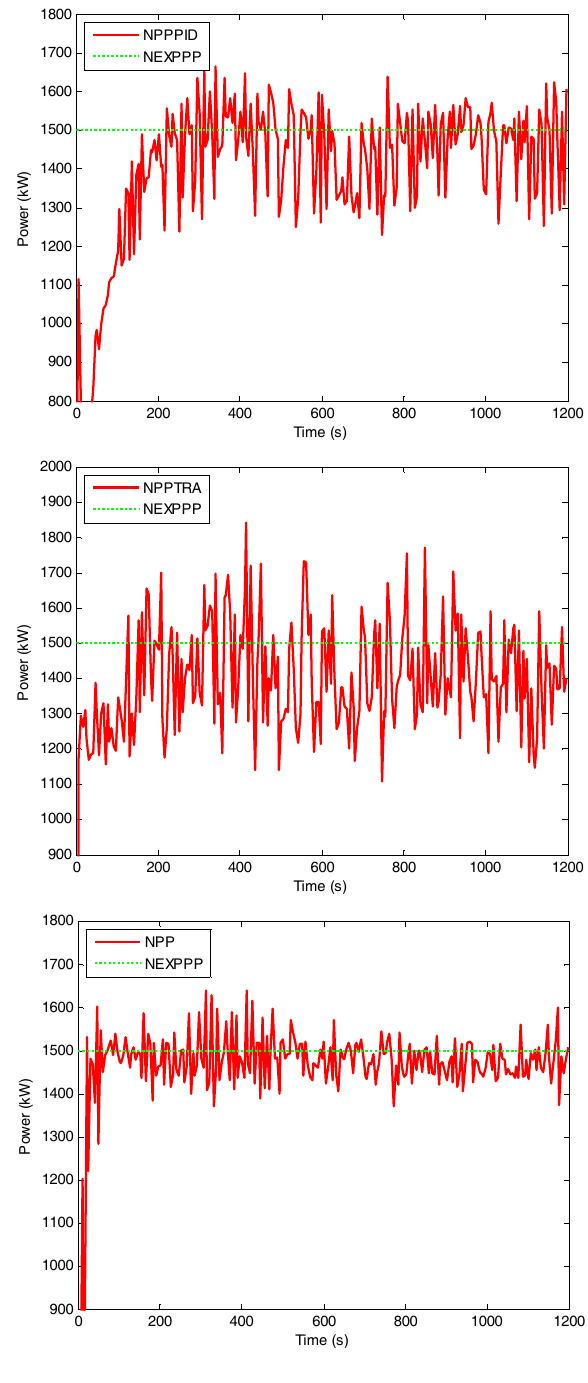
Figure 15. Output power. Figure 15. Output Table 5. Simulation results of turbine rotor speed, speed error and output power.